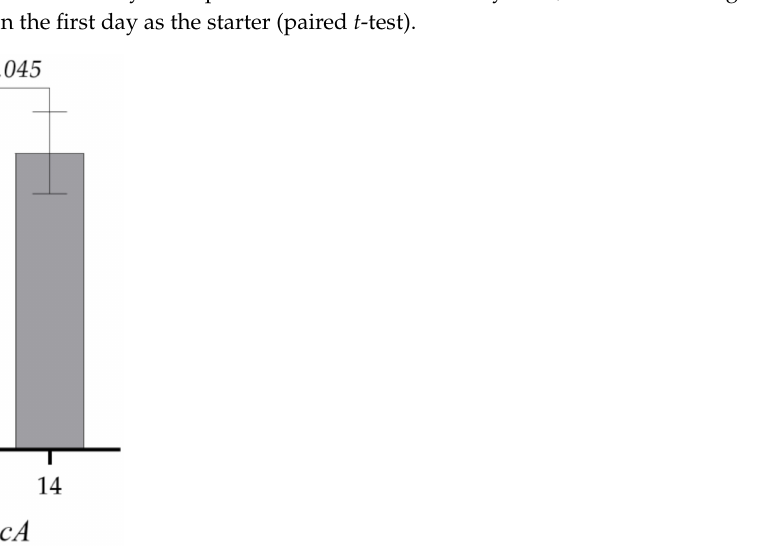
Figure 6. Comparison of mecA gene expression values of test bacteria 14 and 22 , which developed resistance to oxacillin after 30 days of exposure to aluminum chlorohydrate, and the control group test bacteria, which developed resistance to oxacillin following subculturing only in LB broth without aluminum chlorohydrate for 30 days (paired t -test). Table 5. Relative fold change in mecA gene expression levels of test bacteria 14 and 22 , which developed resistance to oxacillin after 30 days of exposure to aluminum chlorohydrate, and the control group test bacteria, which developed resistance to oxacillin following subculturing only in LB broth without aluminum chlorohydrate for 30